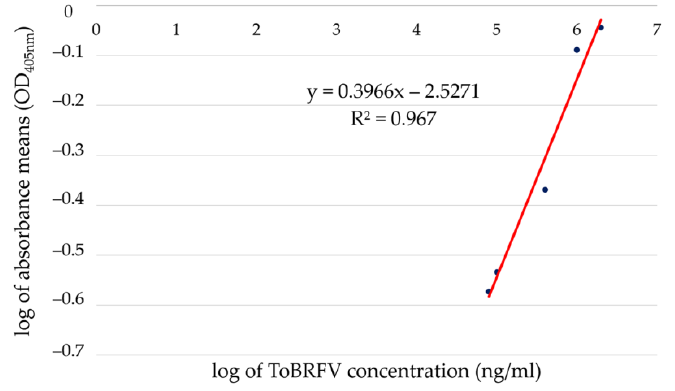
Figure 1. Standard curve for calculating the concentration of target ToBRFV in the samples plotted on log/log scale, 60 min after addition of substrate. Both X and Y axes are on a logarithmic scale. qELISA was carried out with RT-1236 DAS-ELISA kit (DSMZ, Braunschweig, Germany) using a dilution of 1:1000 ( v:v ) and measurement of optical density (OD 405 nm ) 60 min after substrate addition. Each point on the graph represents the mean of the three parallel readings. Y is the log of mean values of the optical density of each concentration or sample, and x is the log of virus concentration in